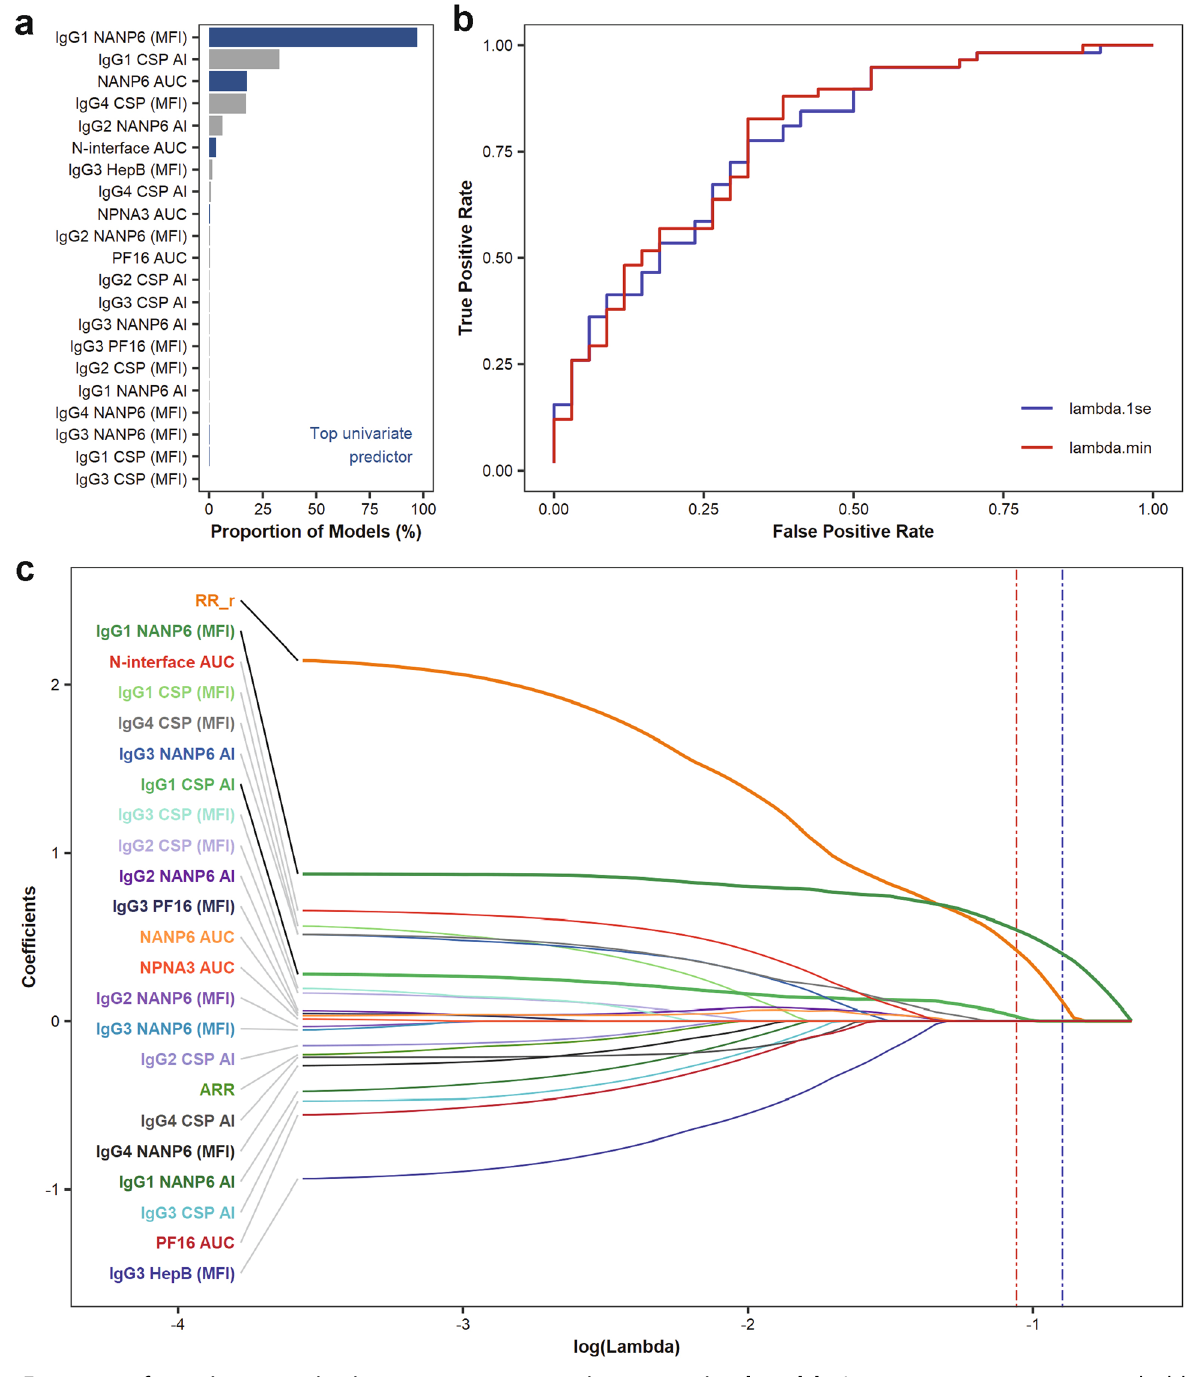
Fig. 5 Frequency of putative protective immune measurements in computational models. Immune measurements are ranked by the proportion of cross-validation LASSO penalized models in which they appear ( a ). Blue bars represent measurements which were found to be associated with protection by univariate analyses. The most frequent measurements, IgG1 NANP6 magnitude and IgG1 CSP AI, also appear in the LASSO penalized model with λ equal to lambda.min, the value of the tuning parameter corresponding to the minimum cross-validation misclassi fi cation error. IgG1 NANP6 magnitude appeared in the LASSO penalized model with λ equal to lambda.1se, the largest value of λ such that misclassi fi cation error was within 1 standard error of the minimum. The ROC curves for these models are shown ( b ) and had AUC values of 0.788 ( λ = lambda.min, red curve) and 0.779 ( λ = lambda.1se, blue curve). The coef fi cients for the included measurements are shown along the entire path of λ values ( c ), with lambda.min and lambda.1se indicated by the vertical red and blue lines, respectively. Each colored line corresponds to either a regimen indicator, RR_r or ARR (0 or 1 value, where 1 = yes), or an immune measurement. Variables included in the model with λ = lambda.min are represented by thicker lines. Smaller values of λ correspond to less penalization and will result in more measurements included in the regression